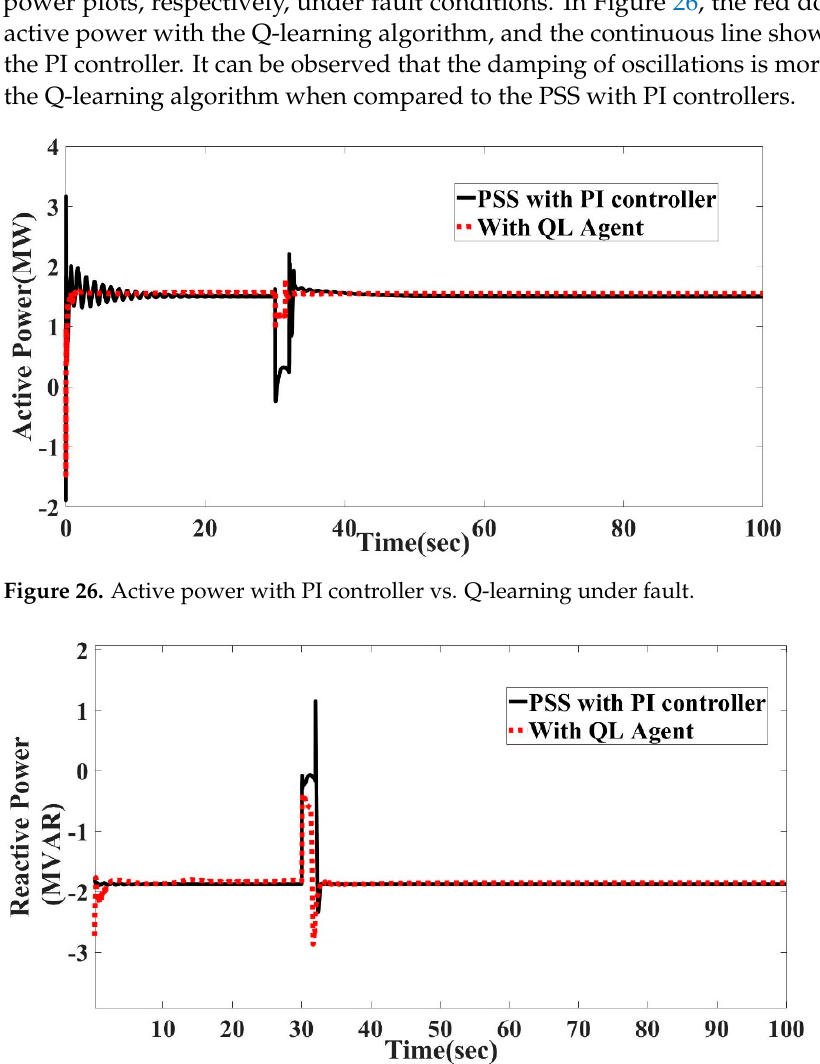
Figure 27 . Reactive power with PI controller vs. Q ‐ learning under fault. Figure 27. Reactive power with PI controller vs. Q-learning under